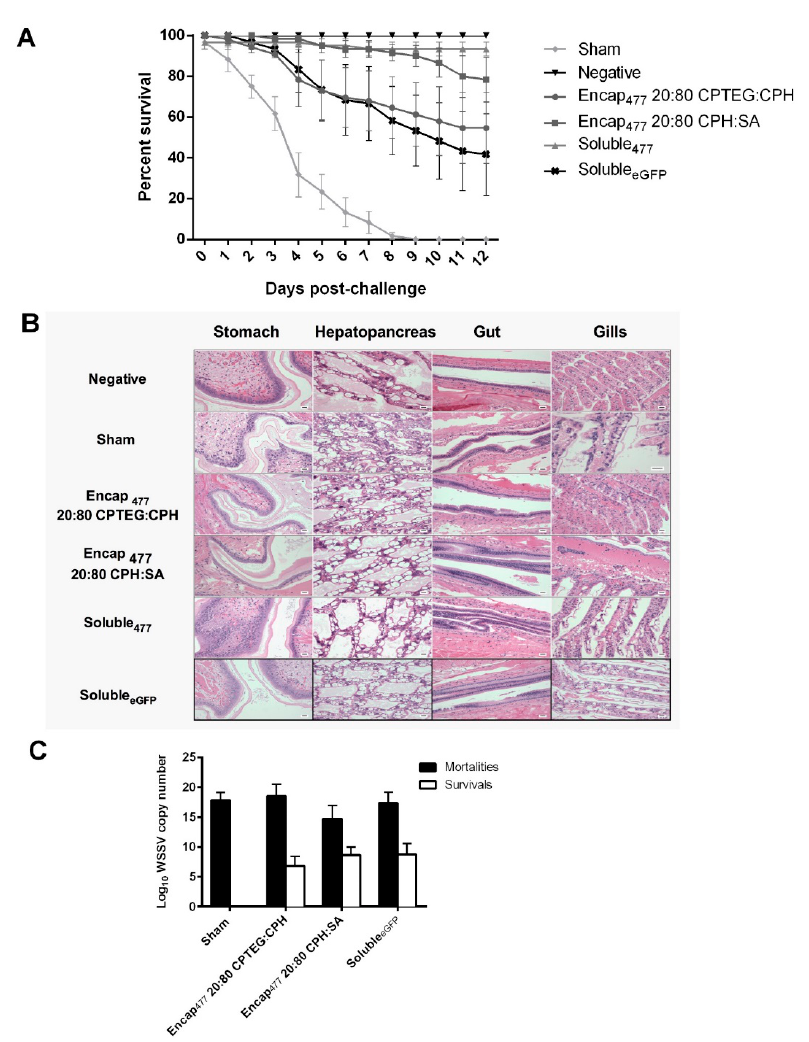
Figure 5. Shrimp survival against WSSV challenge. ( A ) Shrimp were injected by reverse gavage (RG) with 11 µg of either soluble WSSV 477 dsRNA or 11 µg WSSV 477 dsRNA encapsulated in 100 µg 20:80 CPTEG:CPH or 20:80 CPH:SA nanoparticles. Three days postvaccination animals were